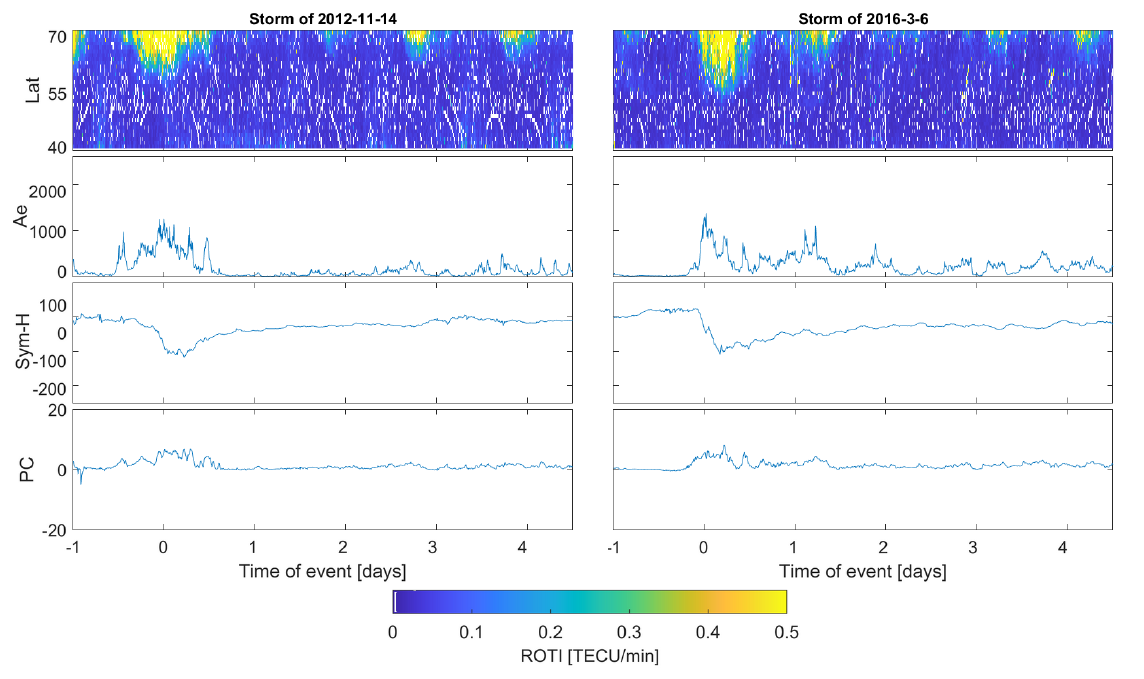
Figure 4. ROTI two − dimensional time series for moderate geomagnetic storms (11 November 2012 and 3 March 2016) compared with Ae, Sym-H and PC indices